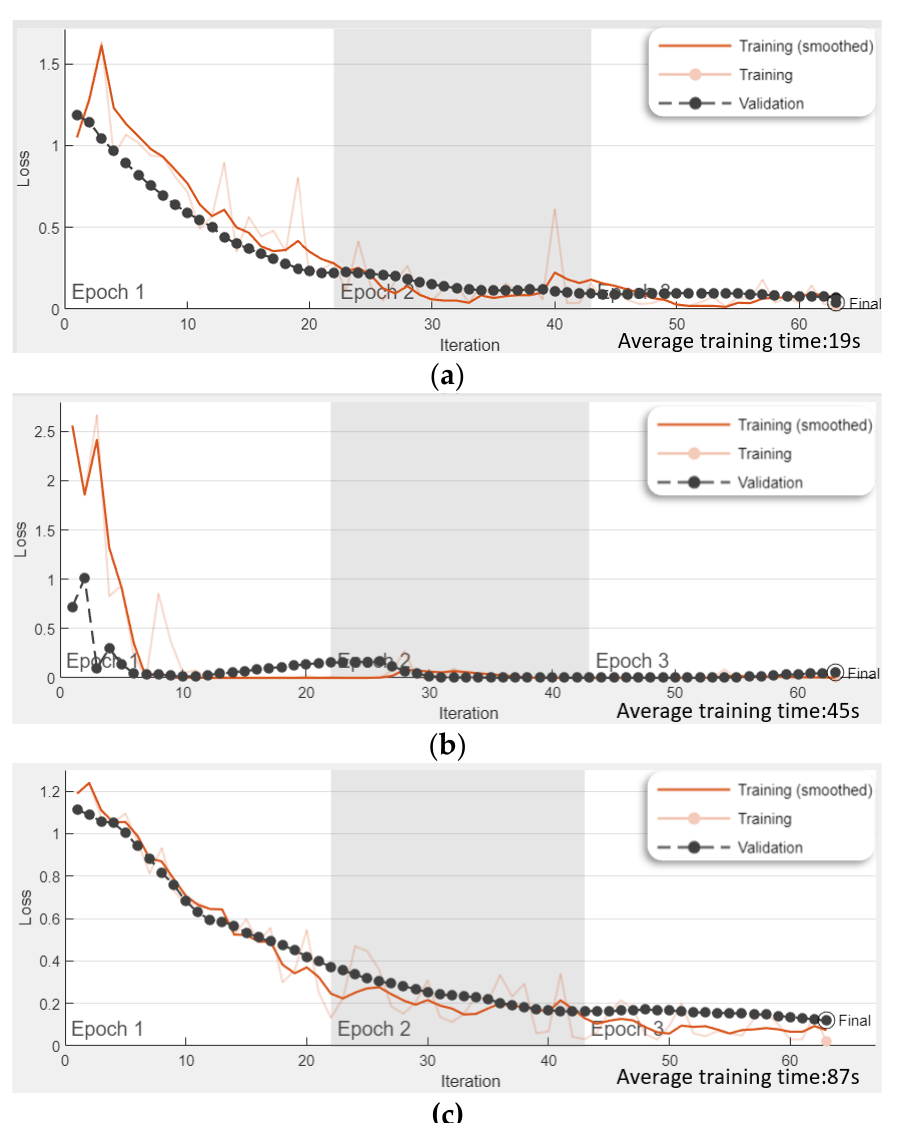
Figure 14. Corresponding loss functions under the best results: ( a ) ResNet Method1, ( b ) AlexNet Method2, ( c ) ResNet Method3.